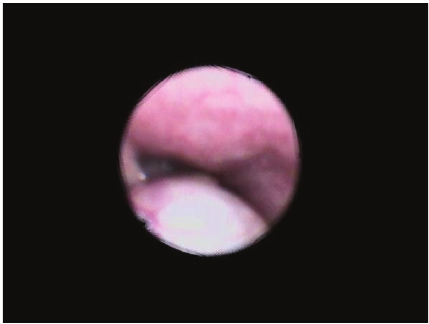
Figure 3: Axial CT scan showing a retroglossal fairly defined rounded nonenhancing hypodense cystic lesion measuring about 9 mm, seen projecting into oropharynx.